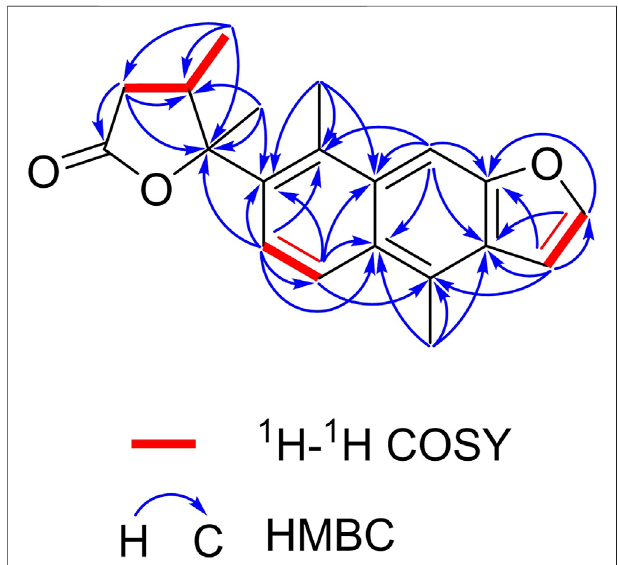
FIGURE 2 | Key 1 H – 1 H COSY and HMBC correlations of caesalpinbondin A ( 1 ).